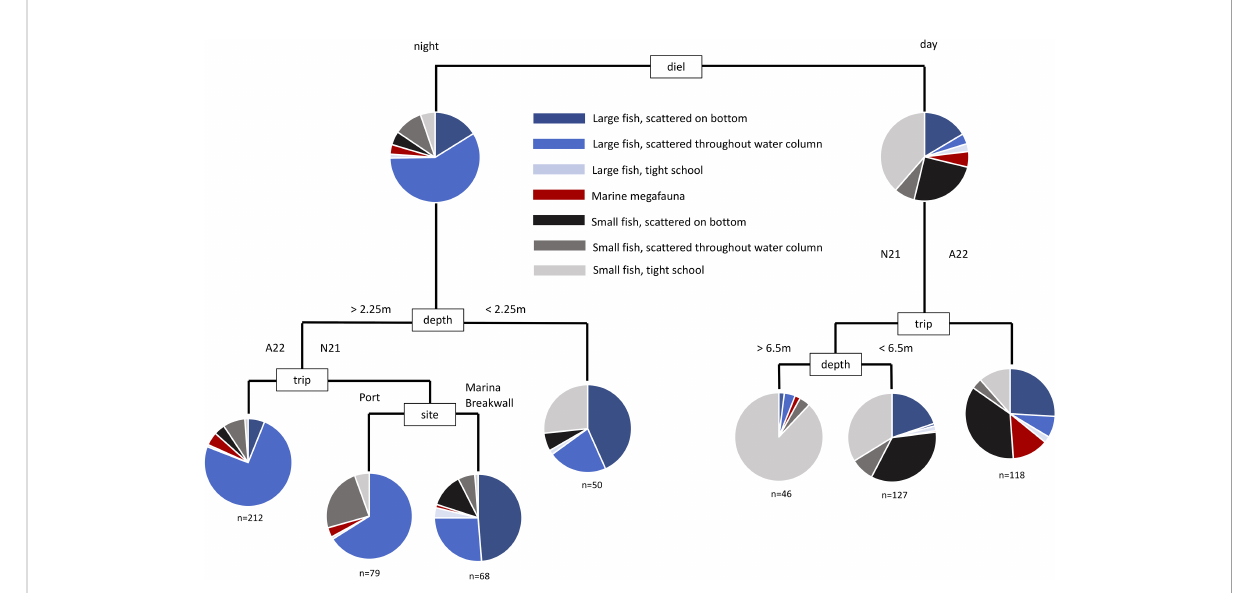
FIGURE 3 Multivariate classi fi cation and regression tree of the assemblage of mobile marine fauna from sonar sampling conducted in Mackay Harbour. Sites were replicated at every sampling event, across day and night, and across two seasons (see Table S1).